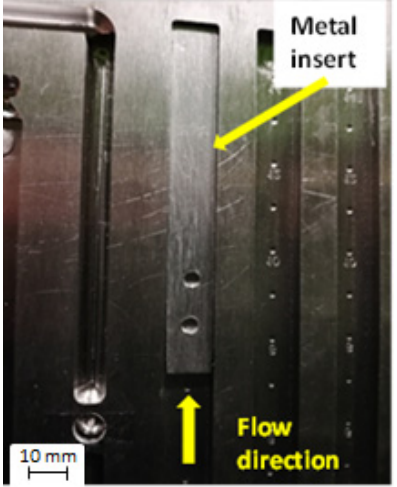
Figure 2. Injection-mold cavity with attached metal insert.